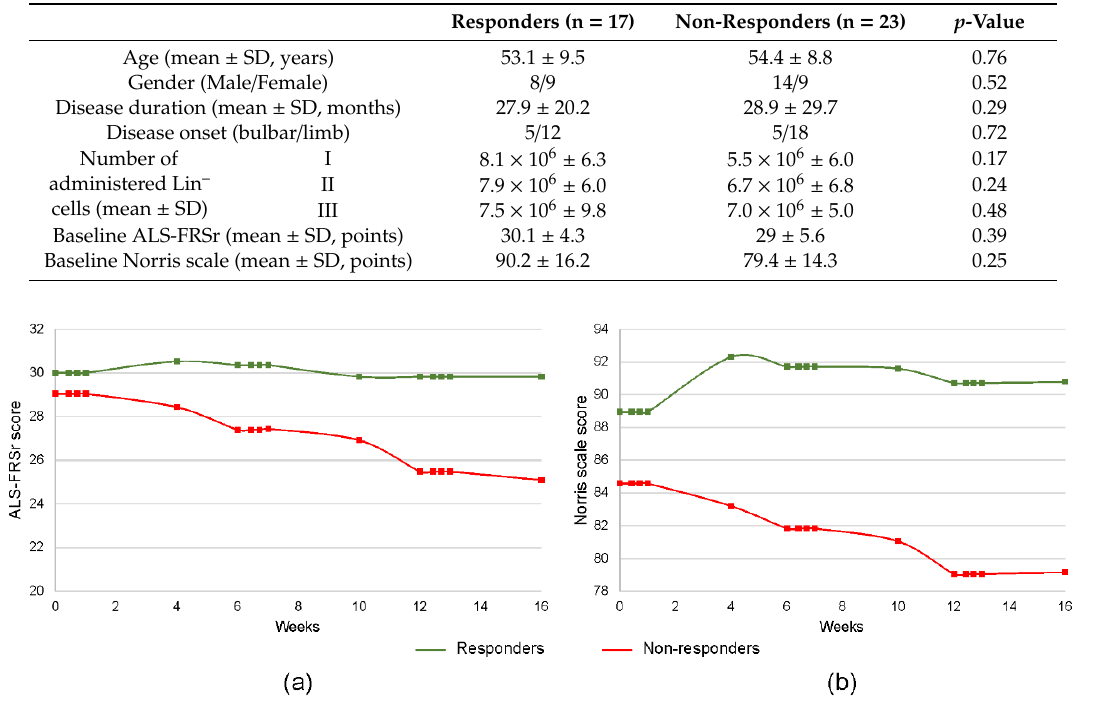
Figure 1. Results of the ALS-FRSr ( a ) and Norris scale ( b ) assessments for two groups: responders (green, n = 17) and non-responders (red, n = 23).